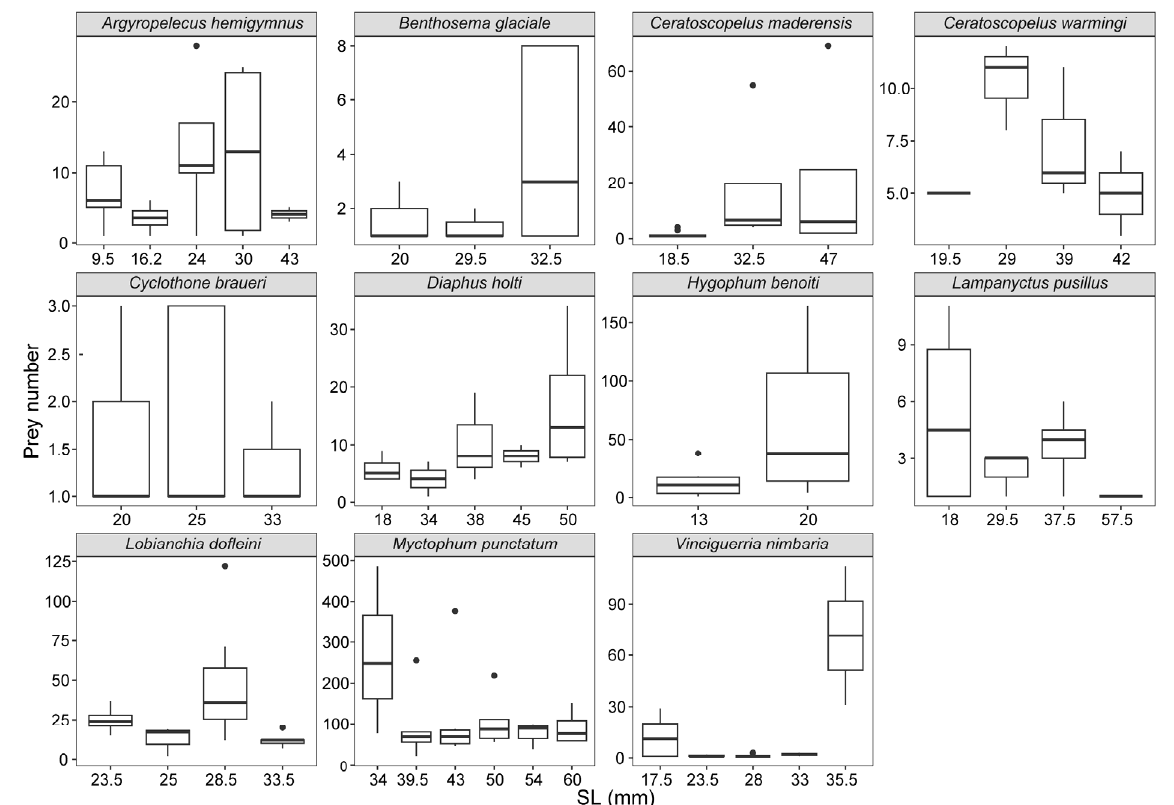
Figure 5. Boxplots for each mesopelagic species showing mean prey number versus standard length (SL (mm)). The line in the box indicates the median value of the data and the upper and lower edges of the box, and the first and third quartiles, respectively. The whiskers extend to 1.5 times the interquartile range. The points outside the ends of the whiskers are outliers. The ticks on the X-axis indicate the end of the size interval for each species. Boxplots for the species are displayed in alphabetic order.